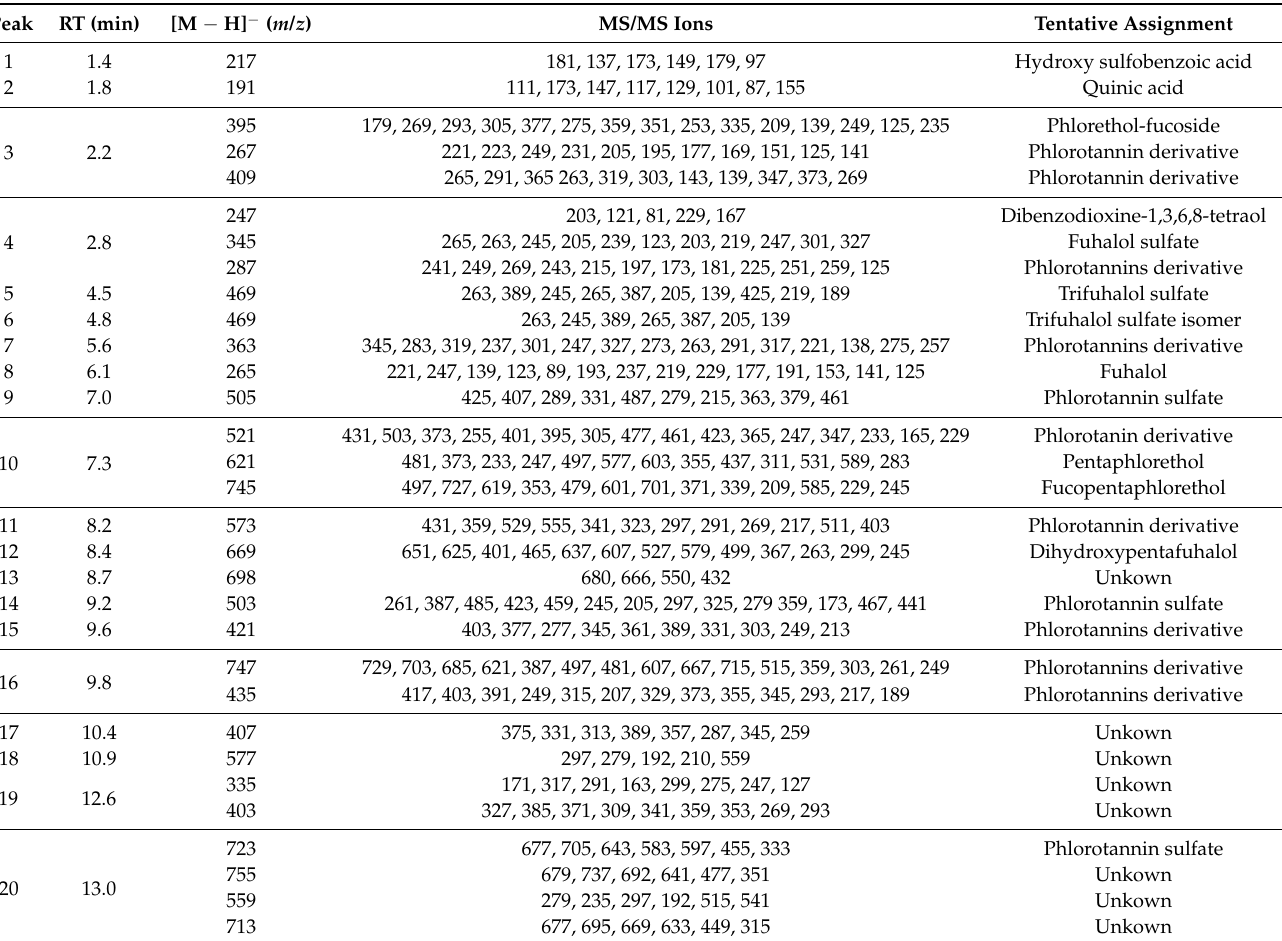
Table 5. Tentative assignment of the compounds present in the ethyl acetate fraction of S. vulgare extract analyzed by LC-ESI-MS/MS.